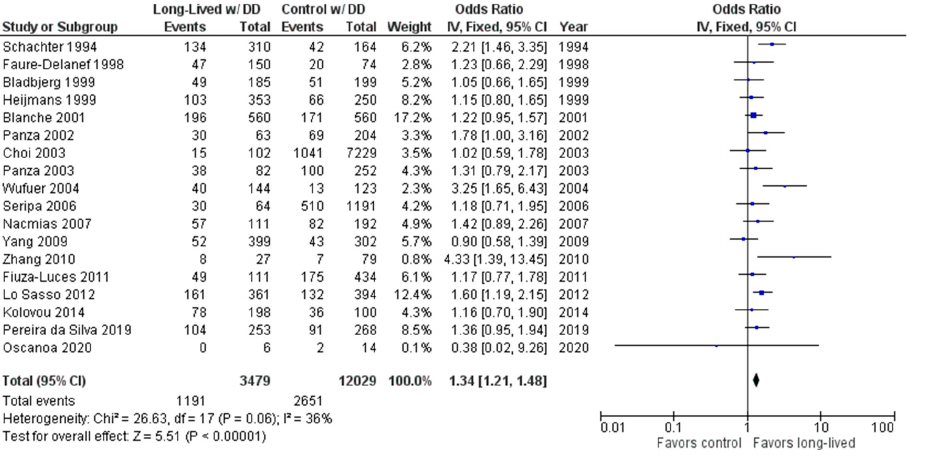
Figure 6. Comparison of ID genotype frequency in long-lived and control groups. The ages of long- lived and control groups are described in Table 1. The p- value is indicated by P in the Figure.